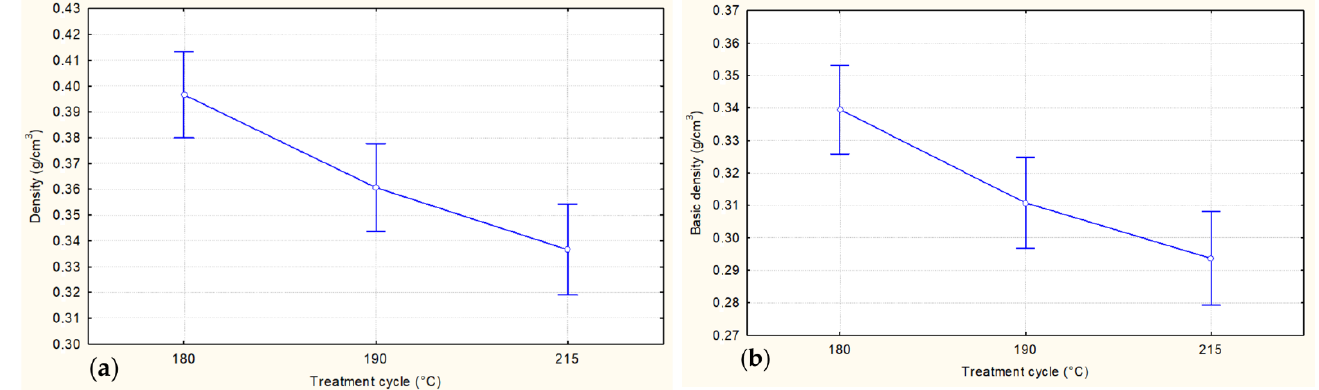
Figure 1. Results of the ANOVA test for density ( a ) and basic density ( b ) of ayous wood after three different heat-treatment cycles ( p -values: ( a ) 0.00003; ( b ) 0.0001).